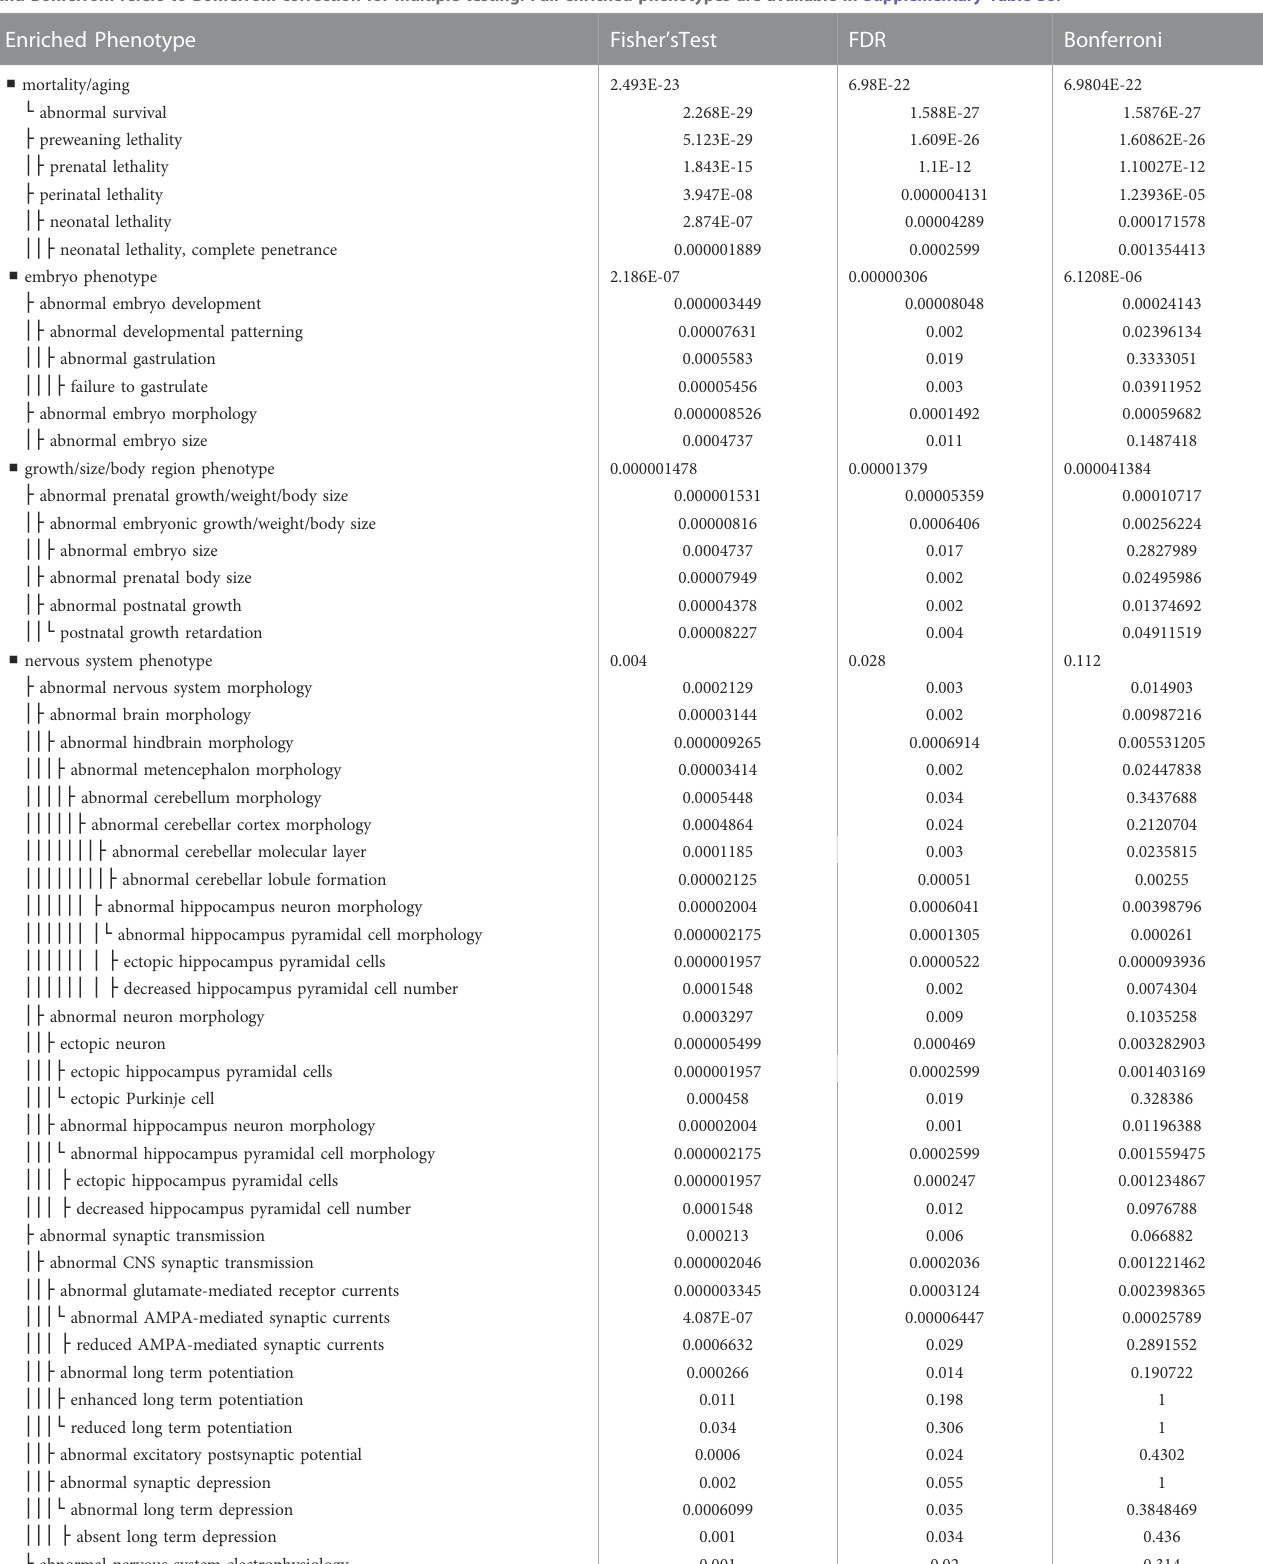
TABLE 7 Phenotype Enrichment of 692 Most Conserved Orthologs (Subset of Most signi fi cant results). Phenotype enrichment for the top 10% most conserved genes from among the core set of 6952 one-to-one protein-coding orthologs across all fi ve species, shrew, ferret, dog, mouse, human and dog. Subset of all phenotype enrichment data (Supplementary Table S8) provides a representative set of enriched phenotypes implicated in development, embryonic/neonatal lethality as well as nervous system morphology, neurotransmitter related phenotypes. Fisher ’ s exact test corresponds to uncorrected p-value, FDR corresponds to False Discovery